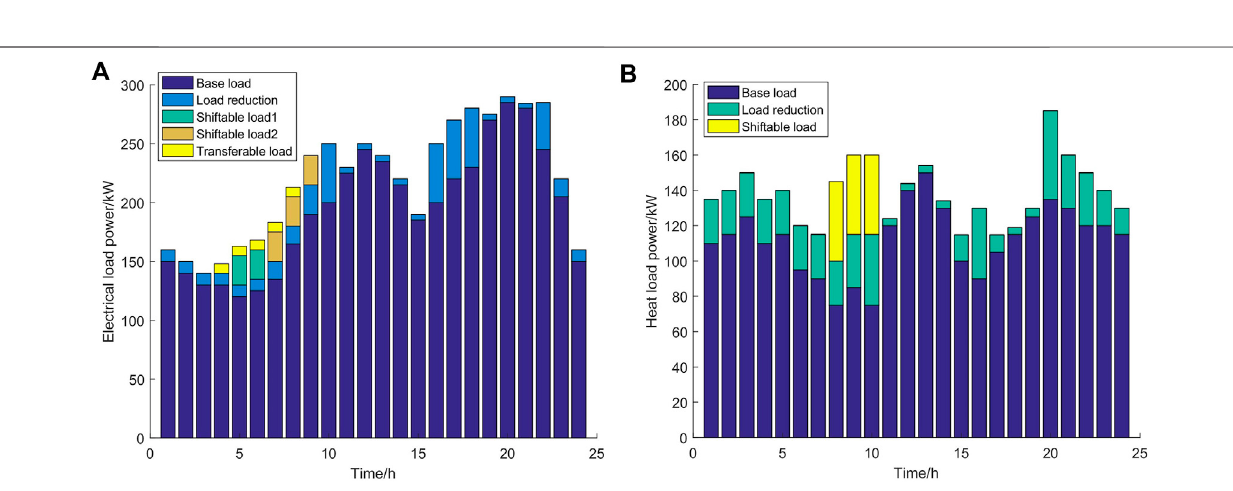
FIGURE 8 | Scenario 1: Distribution of electrical load and heat load after optimization. (A) Electrical load and (B) heat load.